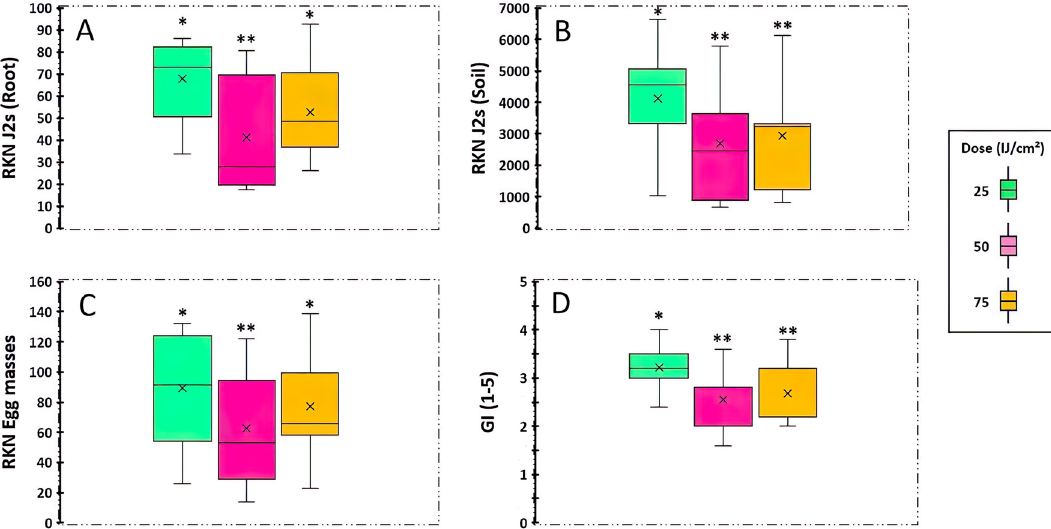
Figure 2. Effect of EPN dose on M. javanica. ( A ) Infective juveniles (J2s) per root system. ( B ) Infective juveniles (J2s) in soil matrix. ( C ) M. javanica egg-masses. ( D ) M. javanica galling index. Stars